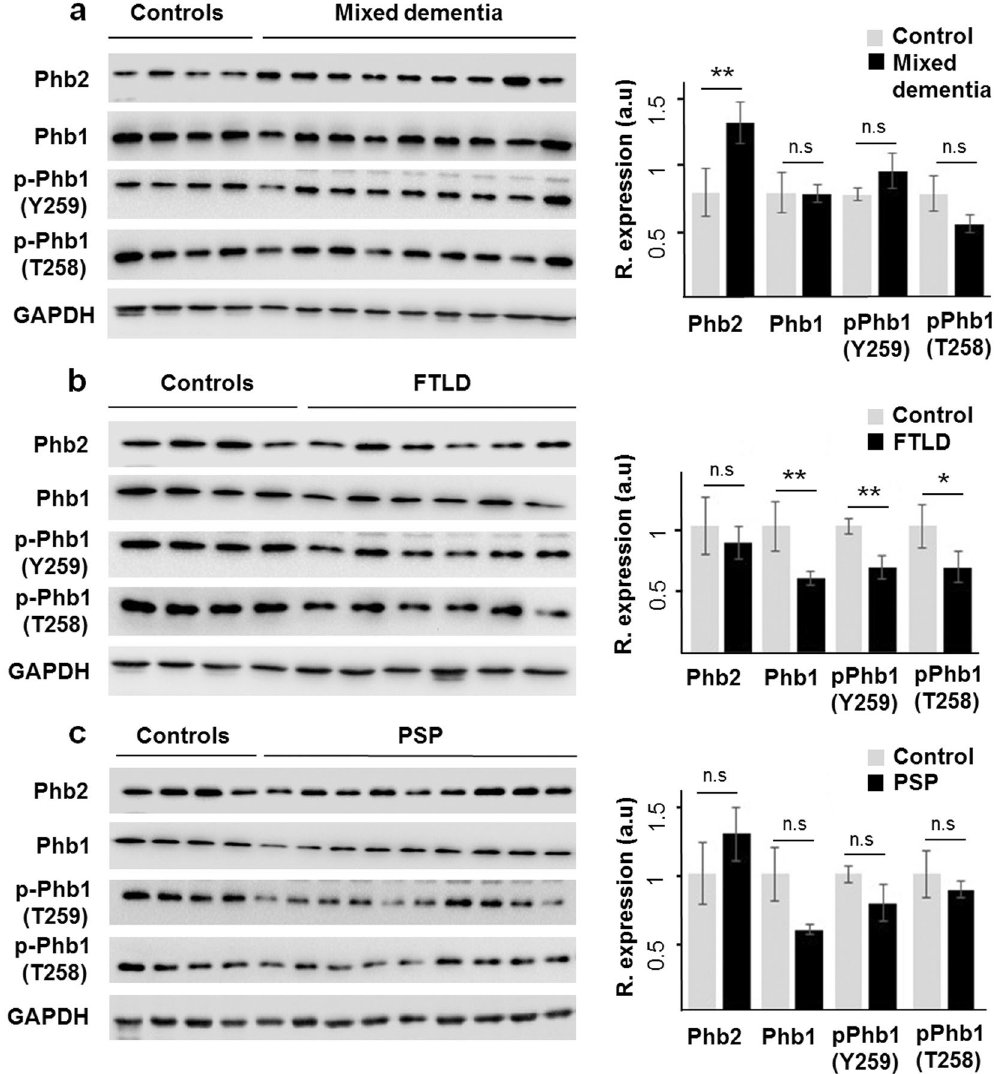
Figure 8. OB protein expression of Phb isoforms across AD-related proteinopathies. Olfactory expression of Phb2, Phb1, and Phb1 phosphorylated isoforms in Mix AD VD ( a ), FTLD ( b ), and PSP ( c ). Representative Western blot gels are shown for each Phb subunit. Histograms of band densities derived from 28 independent OB samples. Data are presented as mean ± SEM from: Controls (n = 4 cases), mixed dementia (mix AD VD) (n = 9 cases), FTLD (n = 6 cases), and PSP (n = 9 cases). * P < 0.05 vs control group; ** P < 0.01 vs control group. Full-length blots/gels are presented in Supplementary